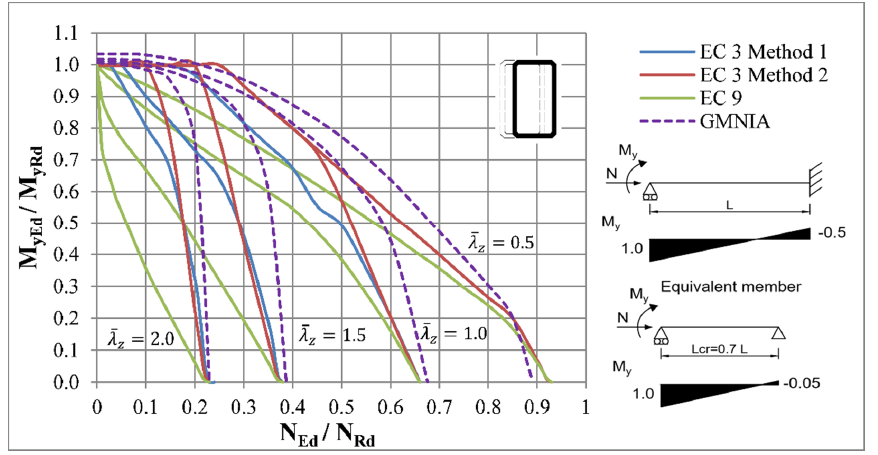
Figure 38. Interaction curves for beam-columns with RHS cross-section without lateral restraints.